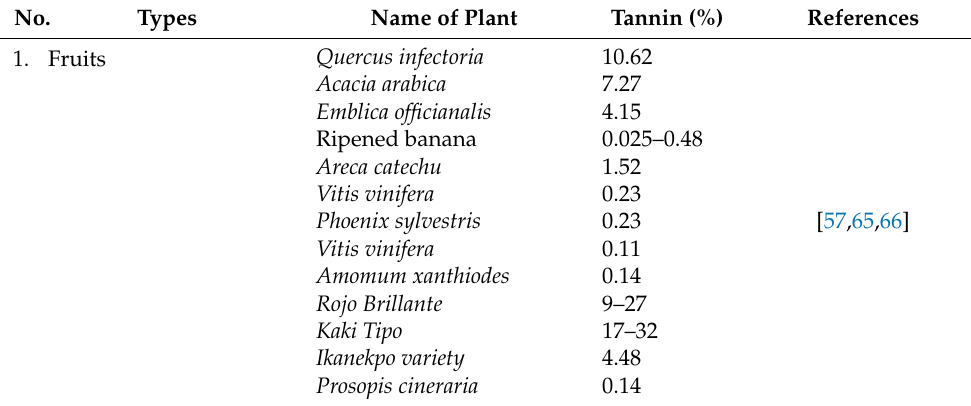
Table 2. Different tannin sources and